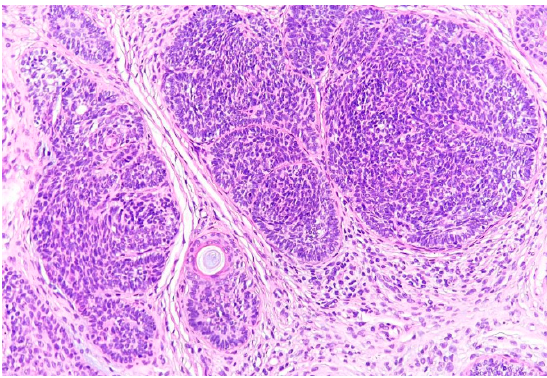
Figure 2. Trichoepithelioma (basaloid cells organized in a lobular pattern similar to that of the basal cell carcinoma, with cribriform aspect due to the horn cysts).